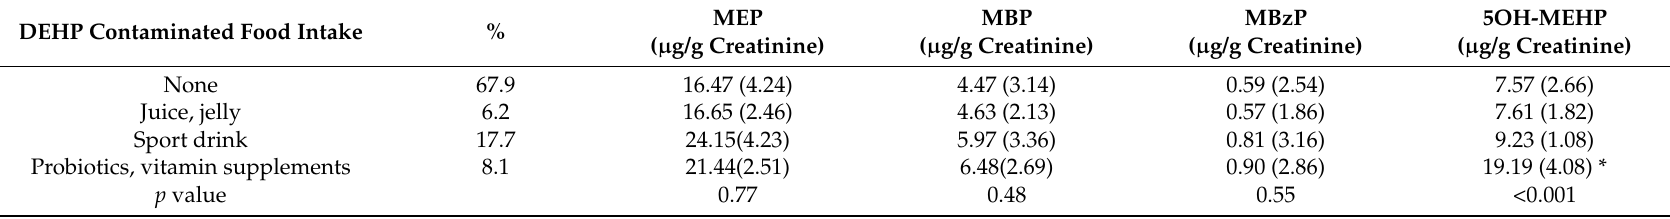
Table 3. Contaminated food items in terms of geometric means (s.e.) of urine phthalate metabolites concentrations in 2010 ( n =